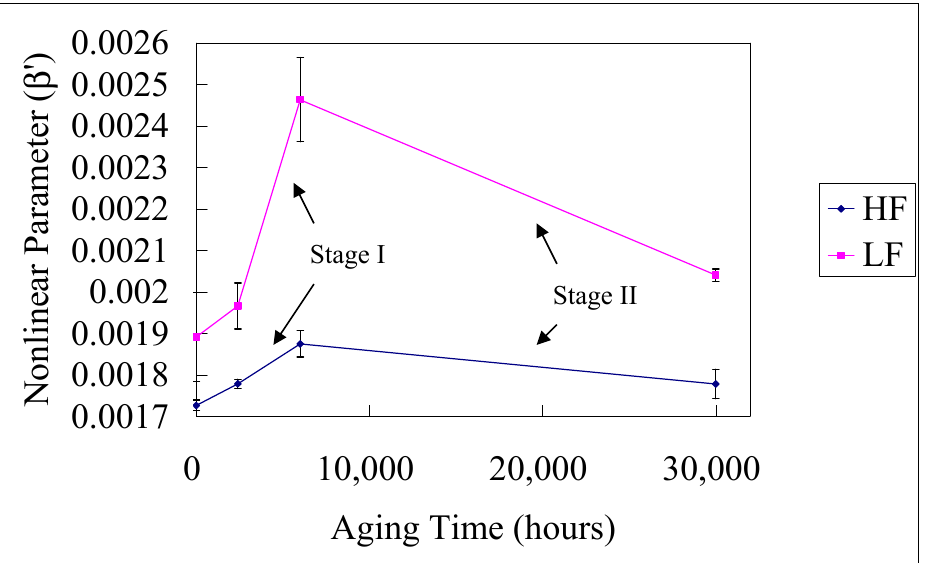
Figure 15. Variations of nonlinear parameters for HF and LF with aging time. Appl. Sci. 2020 , 10 , x FOR PEER REVIEW